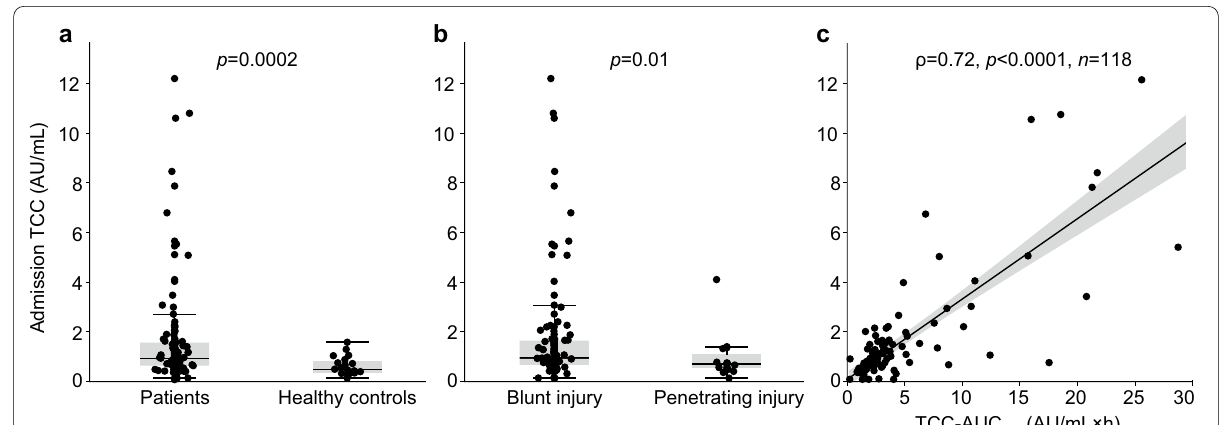
Fig. 3 Admission TCC in patients and controls and relation to mechanism of injury. a Distribution of admission Terminal Complement Complex (TCC) in patients ( n 133) and healthy controls ( n 20). b Distribution of admission TCC values in patients with blunt ( n = = 118), with linear fit and 95% confidence interval for the fitted line (shaded). ρ , ( n 17) injury. c Admission TCC values plotted against TCC-AUC 3–6 ( n = = Spearman’s rank correlation